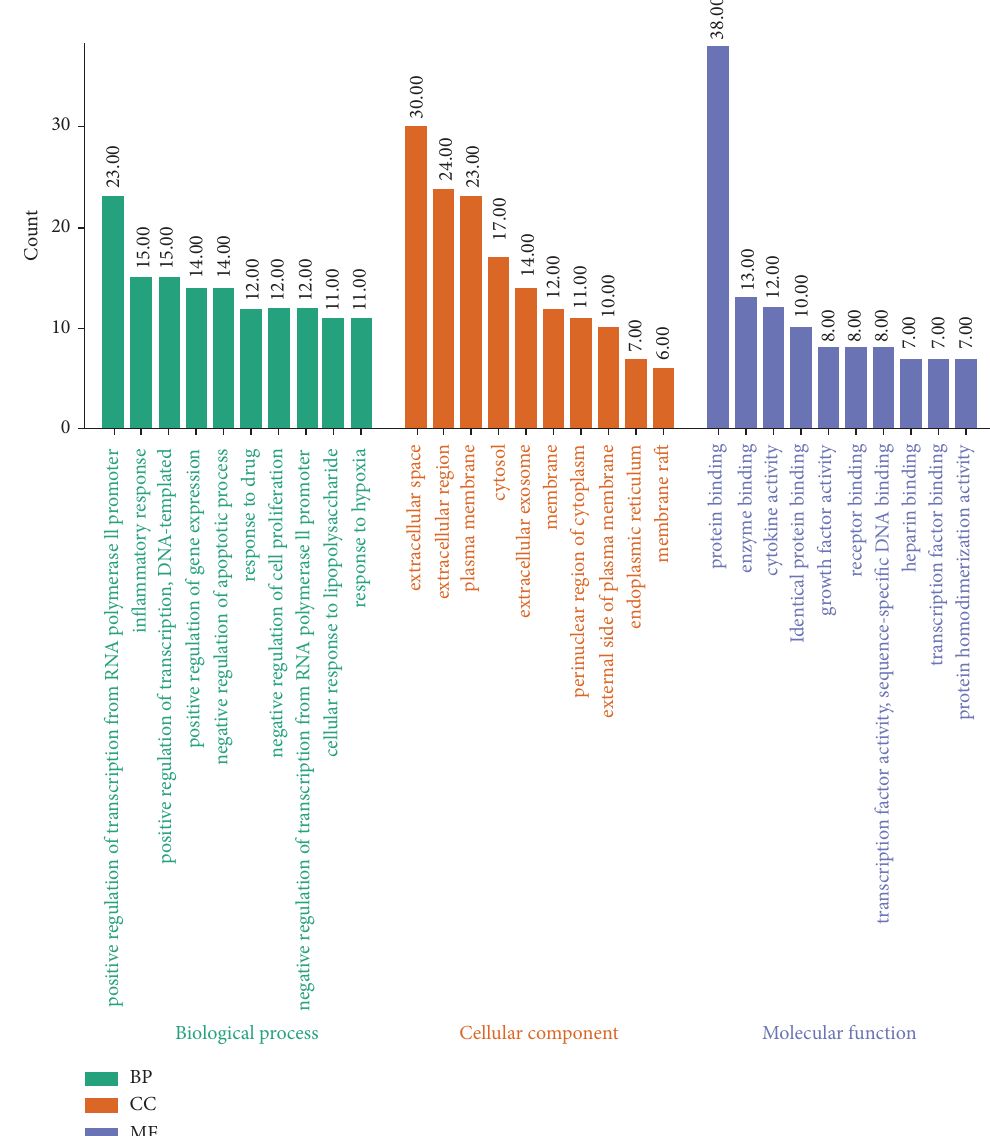
Figure 4: Top 10 in GO